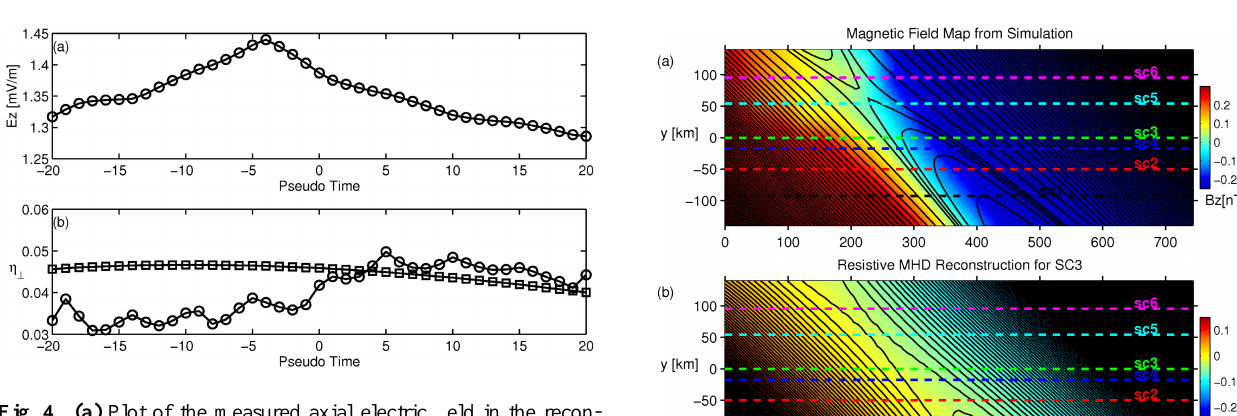
Fig. 5. (a) Plot of magnetic field lines in the reconstruction (x-y) plane, with the axial field B z in color. The map is obtained by projection of the simulation results, evaluated in the x 0 − z 0 -plane, onto the x-y-plane. The reversal of B z across the layer, which is not present in Fig. 2, occurs because the z-axis used in the reconstruction does not coincide exactly with the y 0 -axis in Fig. 2 (they form an angle of 1.3 ◦ ). (b) Resistive MHD reconstruction map of the magnetic field lines (black solid lines) with axial field B z in color, based on data measured by spacecraft 3 at points along its path. The horizontal dashed lines are the spacecraft paths, projected onto the reconstruction plane, relative to which they are tilted by 16.1 ◦ . Some of the color differences between the maps in panels (a) and (b) are caused by this tilt in combination with the weakly 3-D nature of the simulation. Spacecraft 1-4 form a tetrahedron configuration while spacecraft 5 and 6 are used as auxiliaries for verification of the reconstruction